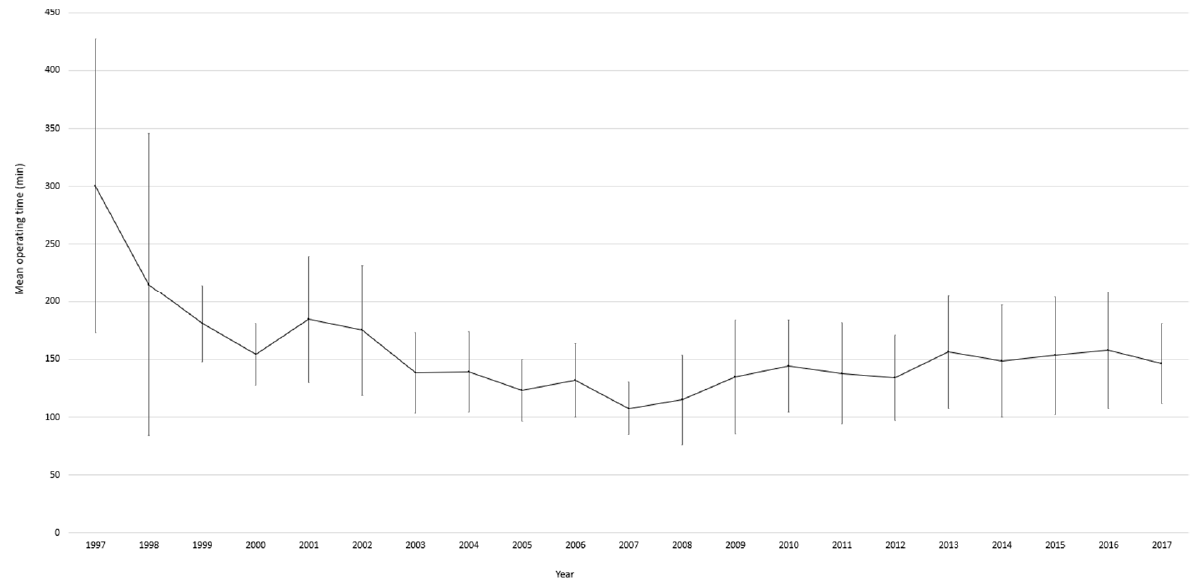
Figure 1. Annual number of operations.